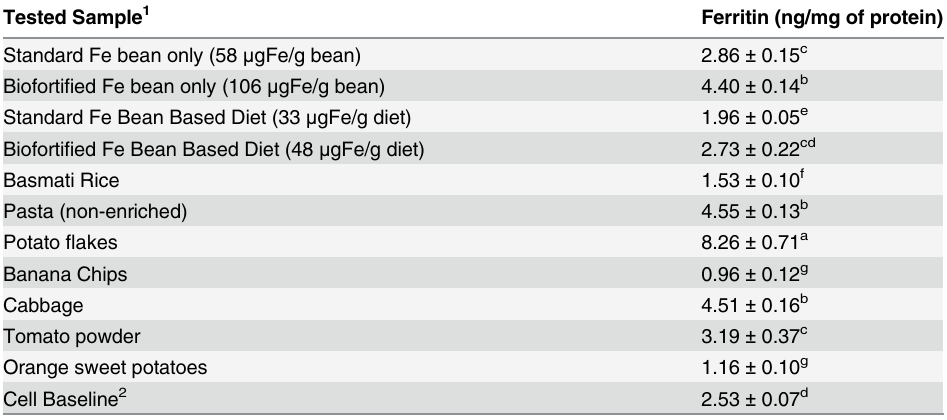
Table 2. Ferritin concentration in Caco-2 cells exposed to samples of beans only (whole bean), addi- tional meal plan components and bean-based diets 1-2 .